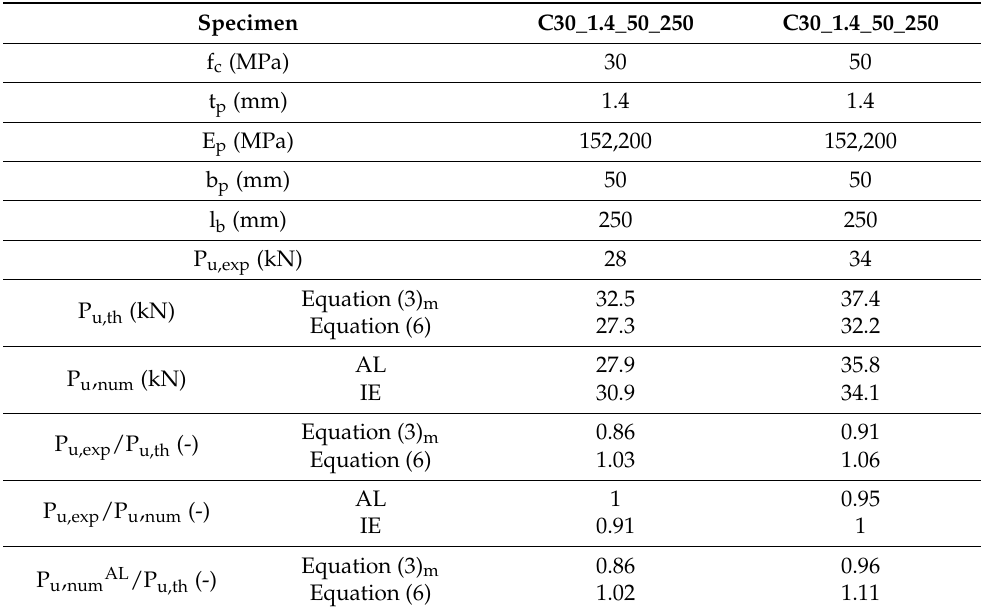
Table 2. Comparison between experimental results of [9] and numerical and theoretical debond- ing